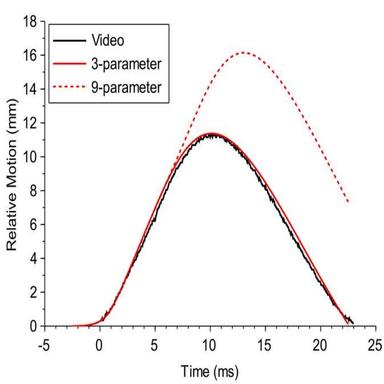
Comparison of gel bulging between the experiment and simulation for Sylgard 527 (1:1). Simulation results from both the current 3-parameter model and 9-parameter model based on oscillatory data.